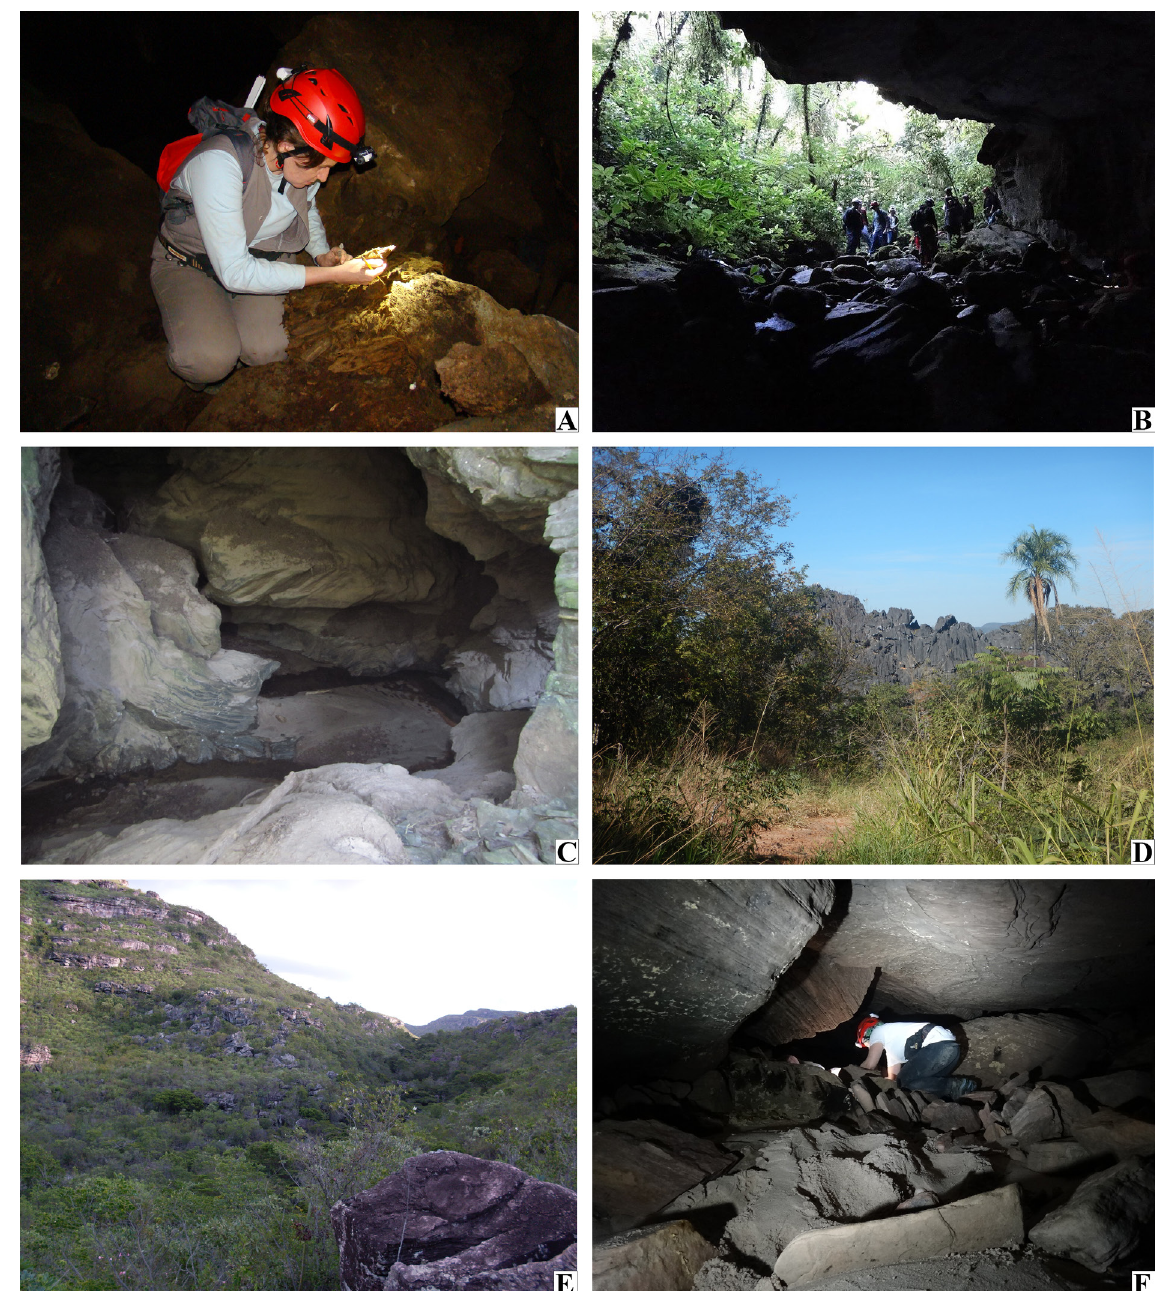
Fig. 1. Study areas. A . Ressurgência das Areias de Água Quente, PETAR. B . Caverna Passoca Cave, PETAR. C . Vereda da Palha Cave. D . Presidente Olegário karst area. E . Surrounding area of Rio dos Pombos Cave, Povoado de Igatu. F . Rio dos